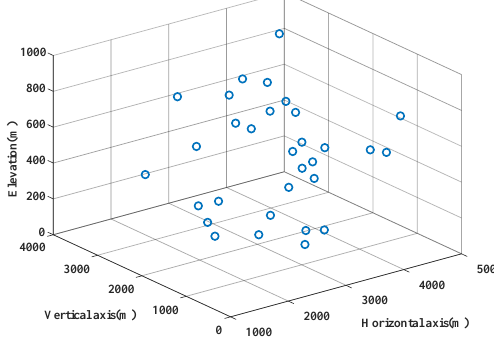
Figure 11. Spatial location map of 31 nodes.